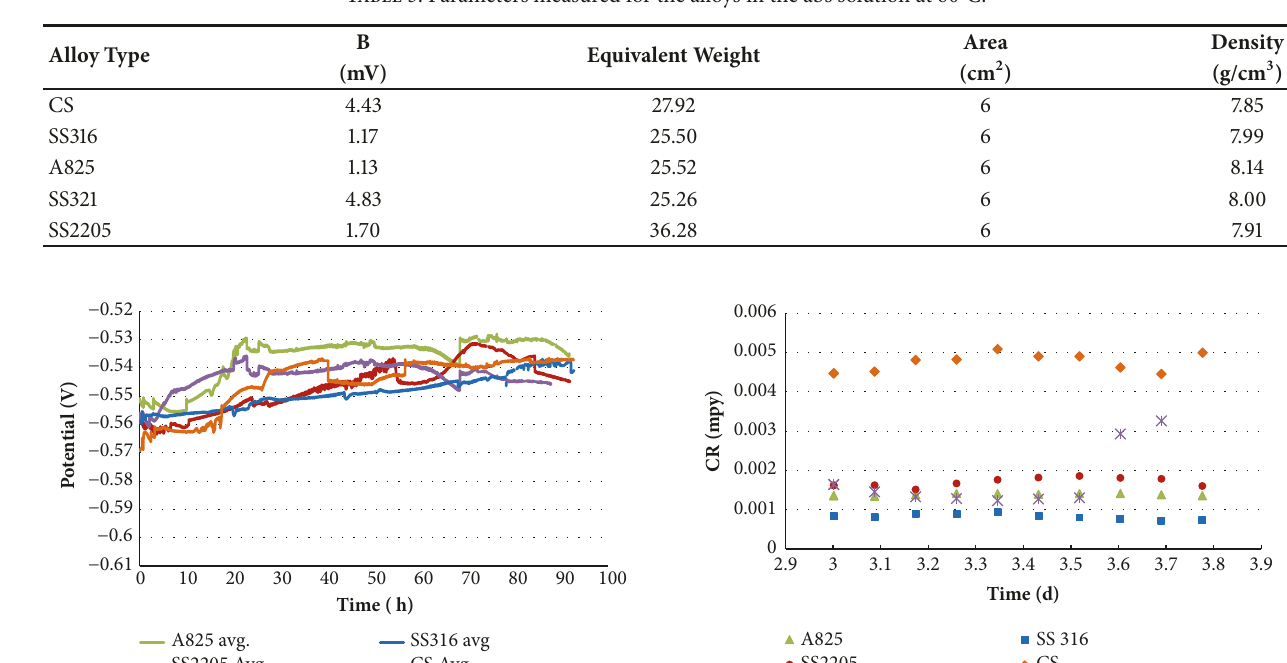
Table 3: Parameters measured for the alloys in the abs solution at 60 ∘ C.